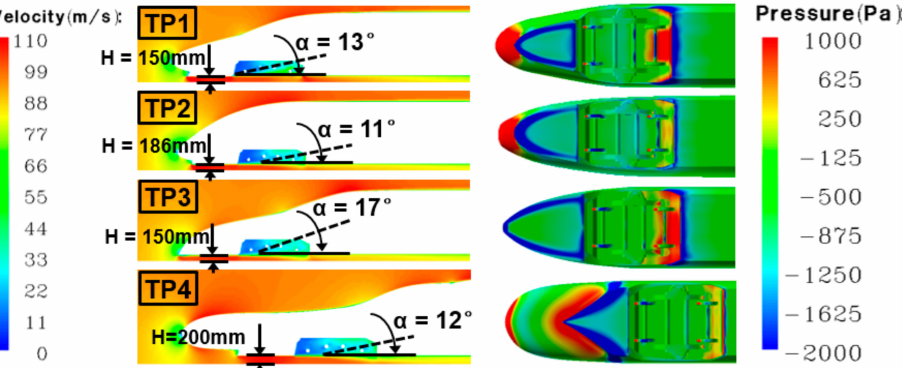
Figure 14. Velocity contour of the longitudinal section at the first bogie region and pressure contour of the first bogie